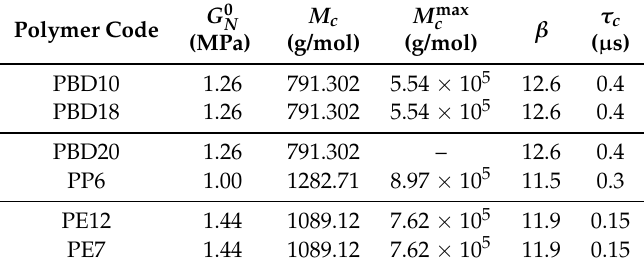
Table 3. Parameters used for our stochastic dynamics for the different polymer melts. M c is calculated from Equations (12) and (13), while β is obtained from Equation (14). M max c corresponds to the heaviest polymer we could simulate whose weight is approximately 700 M c . The computationally unreachable region for simulation is shown as the shaded area in Figure 1. τ c is calculated from the direct comparison with